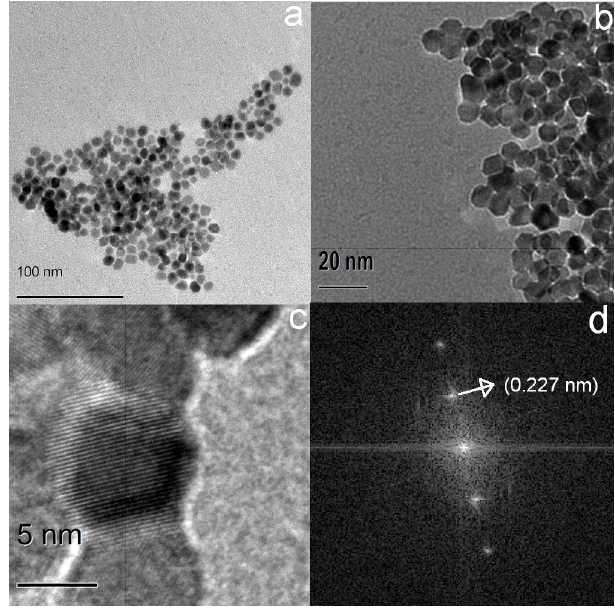
Figure 2. (HR)TEM micrographs of cuboctahedral (co) Pt NPs: ( a , b ) overview; ( c ) HR-TEM; and ( d ) FFT pattern. and ( d ) FFT